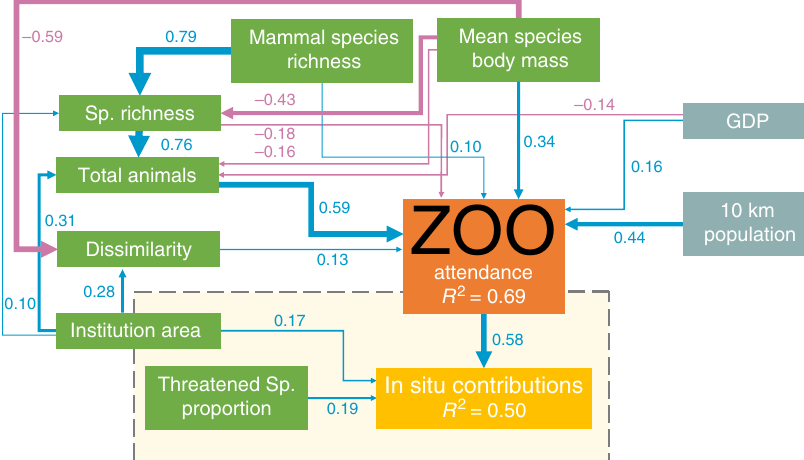
Fig. 2 The SEM framework showing direct and indirect connections between institution attendance ( n = 458), in situ contributions ( n = 119), and various institutional and socio-economic variables. Path coef fi cients shown are standardised. The yellow box indicates the additional pathways included for the 119 institutions for which in situ investment data was available. Blue arrows represent positive effects and pink arrows represent negative effects. Line width represents relative effect sizes. Grey boxes represent socio-economic variables and green boxes represent institutional variables. Source data: model structure and coef fi cients were determined using the Supplementary Code and based on Supplementary Data 1 and 2